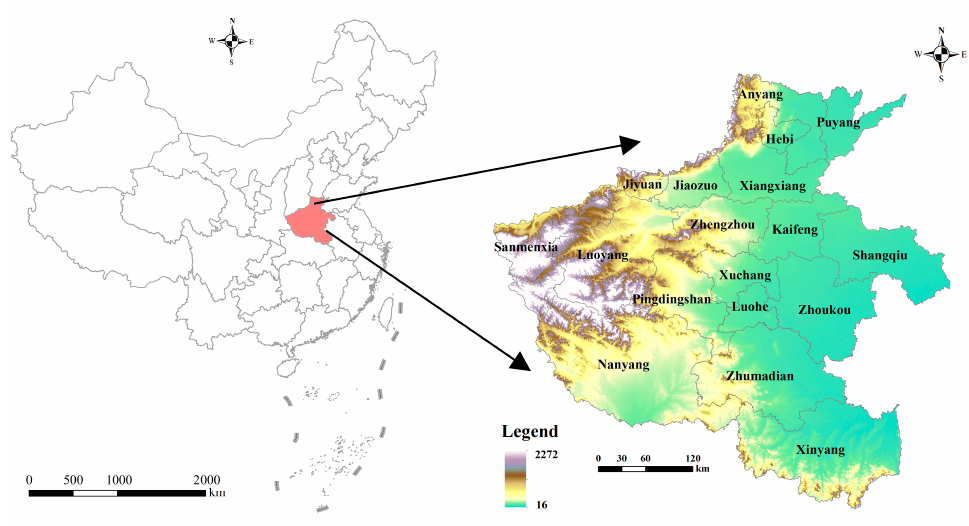
Figure 1. Location of the study